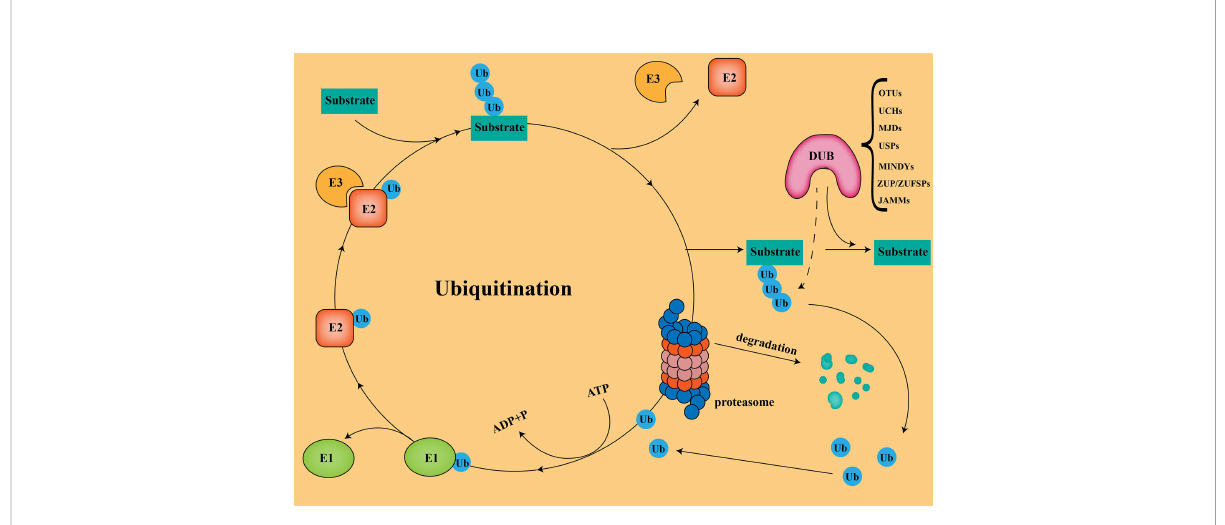
FIGURE 1 Ubiquitination and Deubiquitination The substrate proteins are covalently attached to ubiquitin via isopeptide bonds catalyzed by an E1-E2- E3ligase cascade, followed by proteasomal